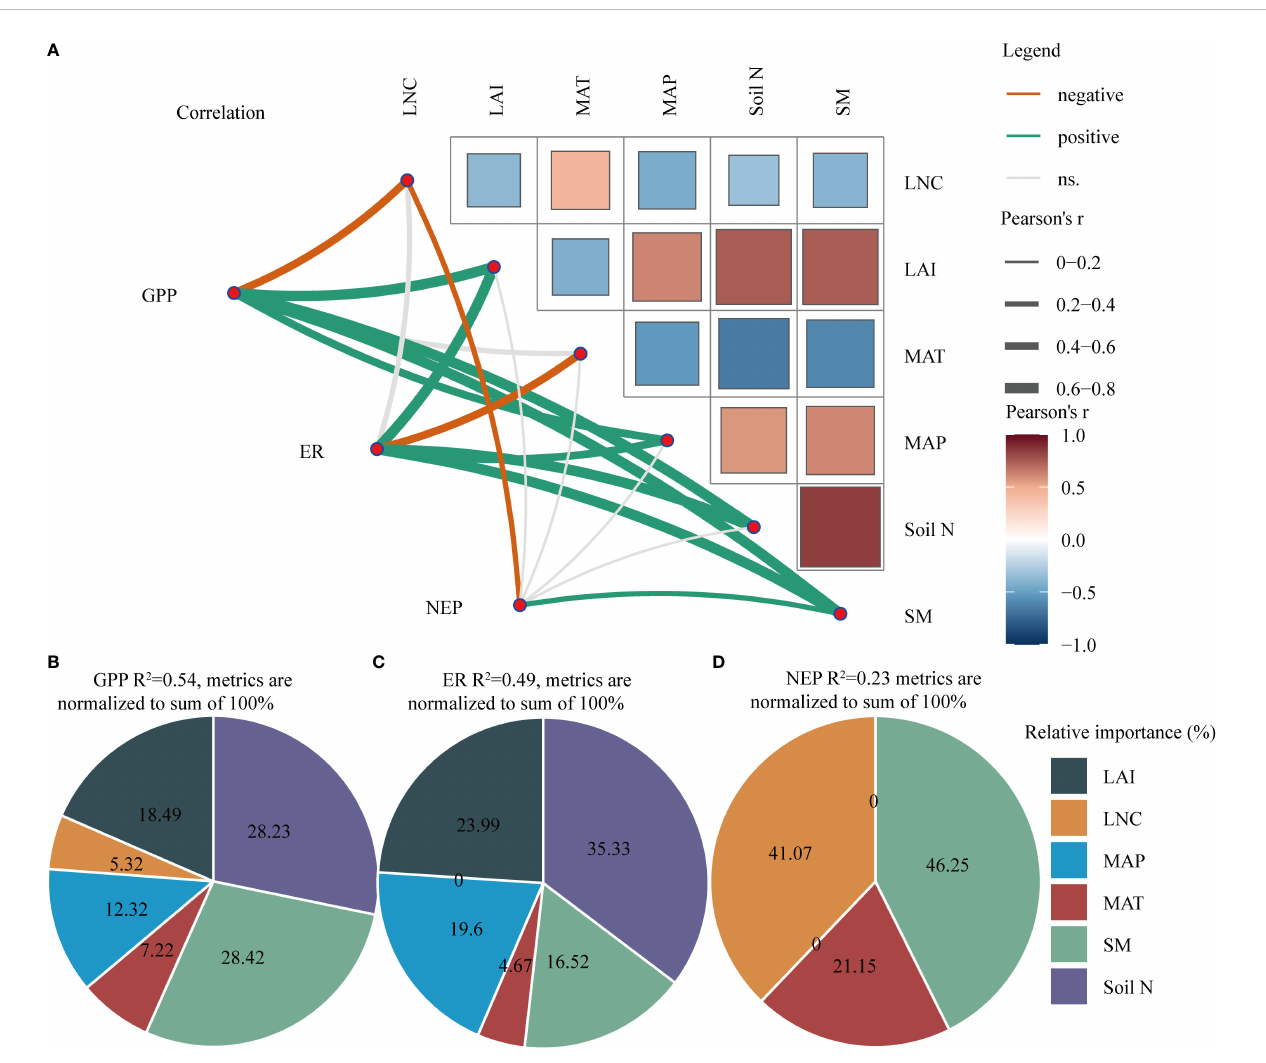
FIGURE 5 (A) Correlation analysis between explanatory variables and carbon fl uxes (GPP, ER, and NEP). (B – D) Hierarchical partitioning analysis between explanatory variables and GPP, ER, and NEP. The thickness of the line indicates the strength of the correlation. The thicker the line is, the stronger the correlation. The orange line represents a negative correlation, whereas a green line represents a positive correlation. MAT, mean annual temperature; MAP, mean annual precipitation; LAI, leaf area index; Soil N, soil total nitrogen content; LNC, leaf nitrogen content; SM, soil moisture; NEP, net ecosystem productivity; GPP, gross primary productivity; ER, ecosystem